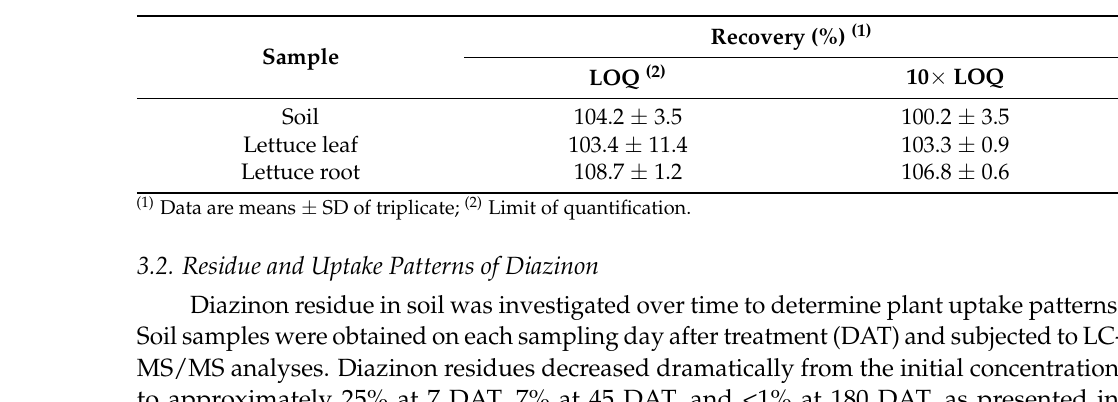
Table 2. Recovery of diazinon fortified in soil and plant